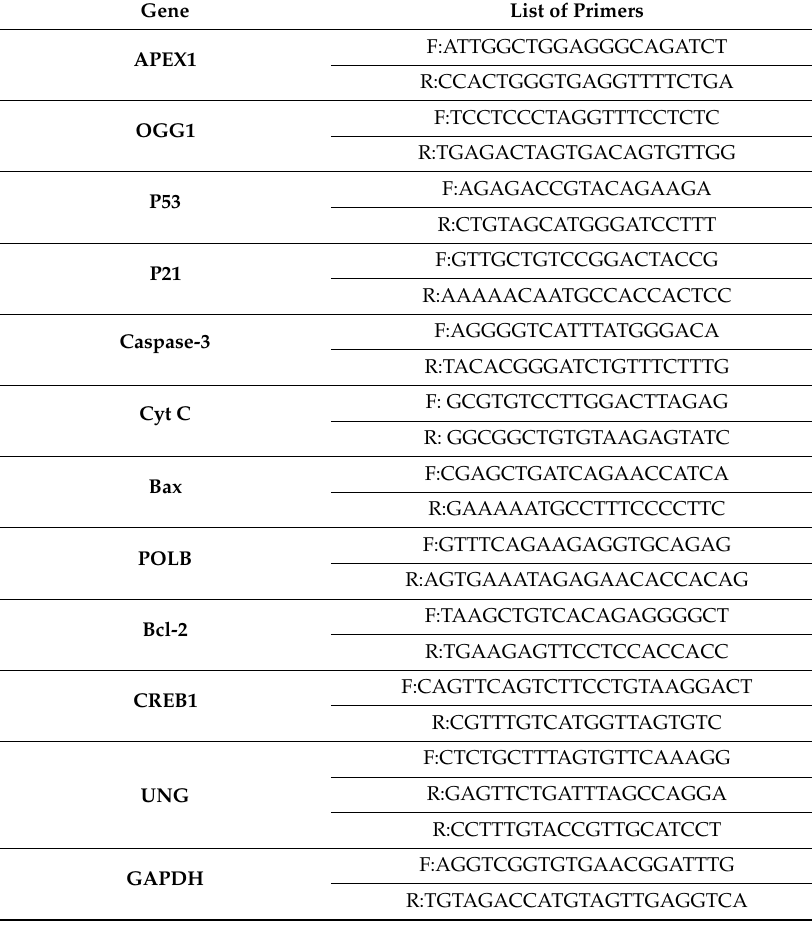
Table 1. List of primers used for quantitative real-time polymerase chain reaction for analysis of apoptotic and DNA damage gene